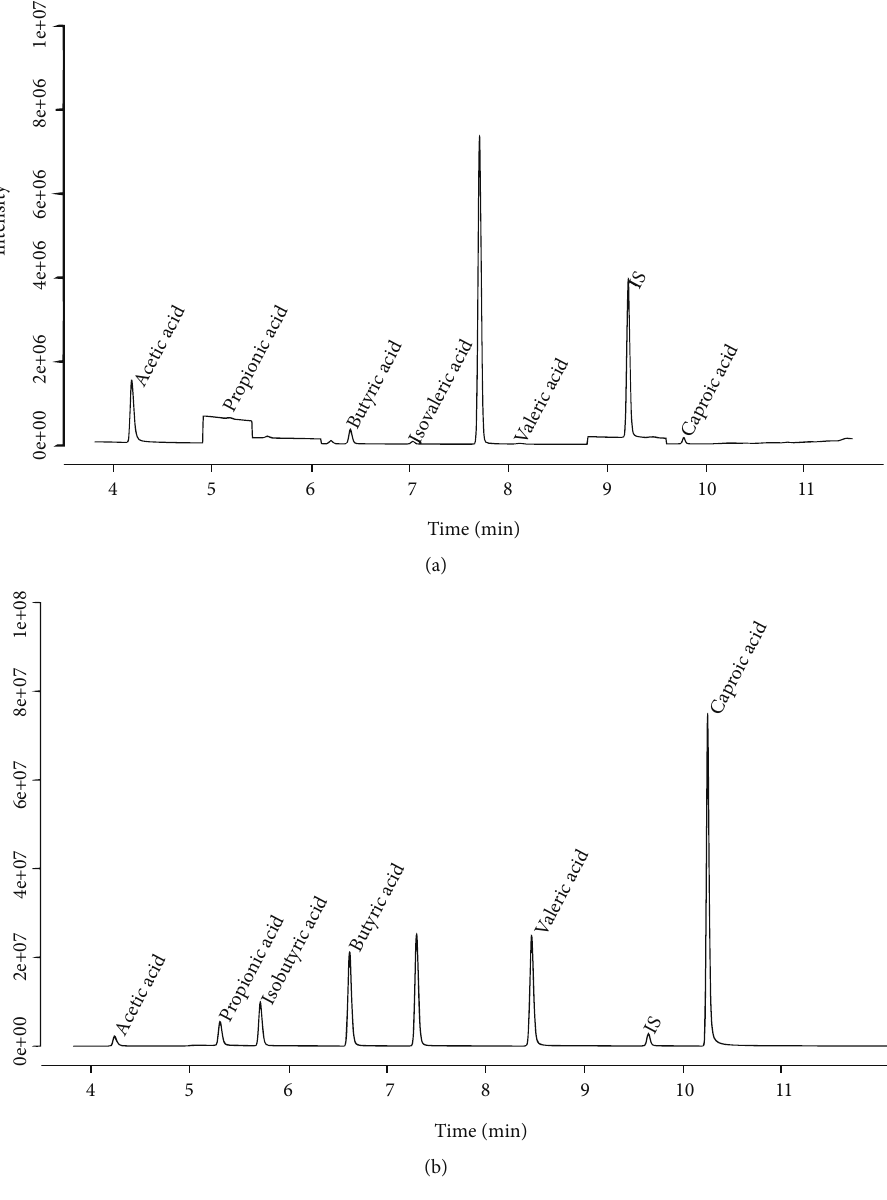
Figure 2: Total ion chromatogram of the SCFAs. (a) The total ion fl ow chromatogram of the SCFAs sample was obtained. (b) The total ion fl ow chromatogram was obtained from the prepared mixed SCFA standard